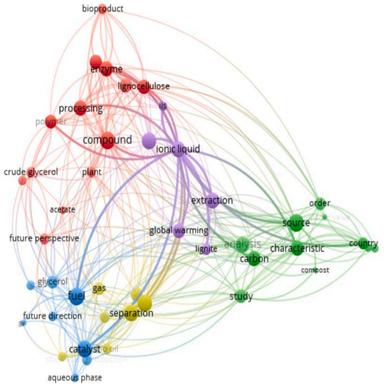
Network visualization of terms associated with ionic liquid-assisted bioconversion from 2G and 3G feedstocks.